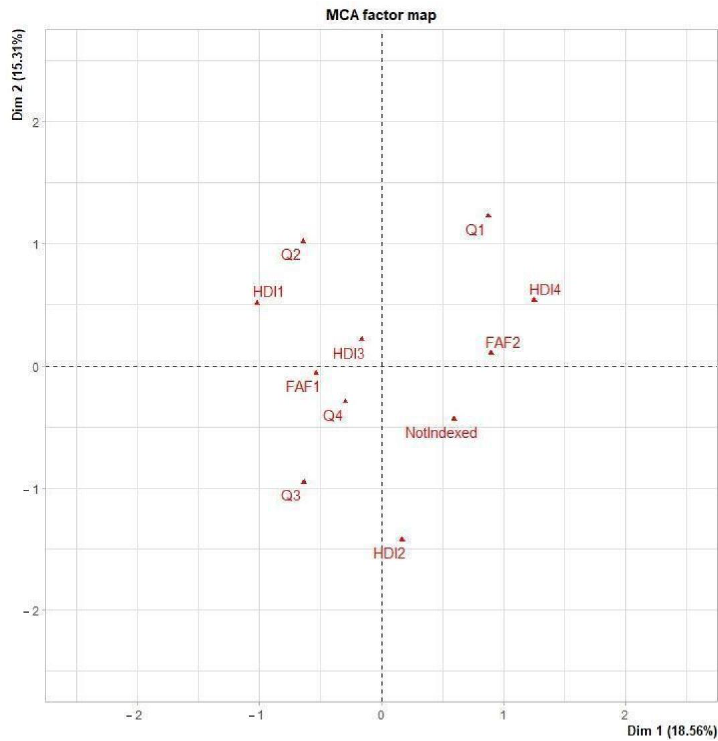
Figure 2. Multiple correspondence analysis for Intimate Partner Violence during pregnancy preva- lence studies. The categories represented on the figures are the following: For the variable FAF: FAF1 represents that the first author is female, FAF2 represents a first author male; for the variable HDI: HDI1 is a very high HDI, HDI2 is a high HDI, HDI3 is medium HDI and HDI4 is a low HID;